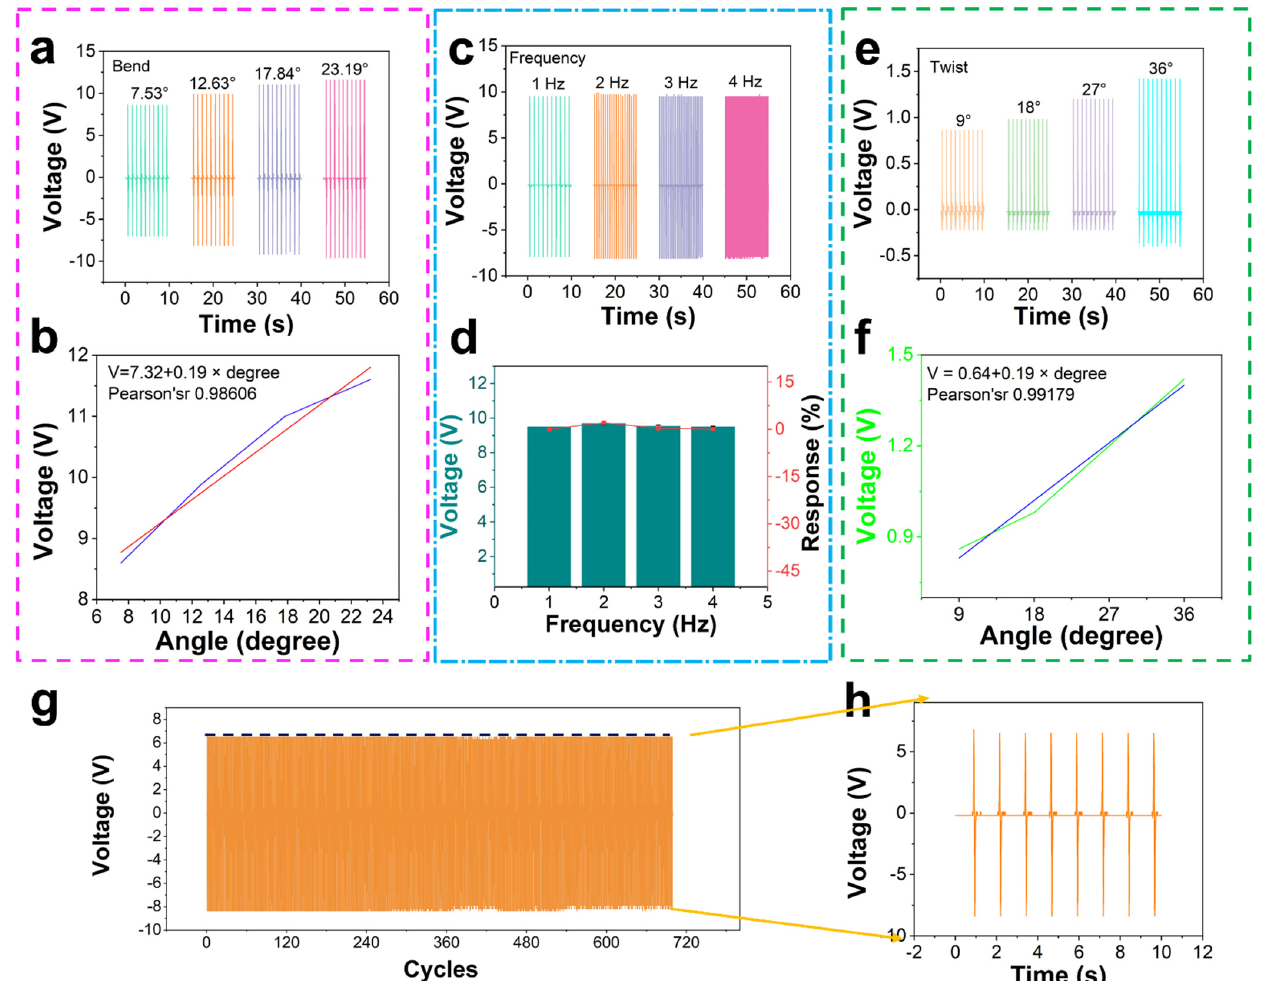
Figure 5. The performance test of PTSS. ( a ) Outputting voltage of PTSS at different bend angles in 100% RH. ( b ) The linear relation of angles and voltages. ( c , d ) Outputting voltage and response of PTSS at different frequencies in 100% RH. ( e ) Outputting voltage of PTSS at different twist angles in 100% RH. ( f ) Linear relation of twist angles and voltages. ( g ) Durability test of PTSS. ( h ) The detail of durability.